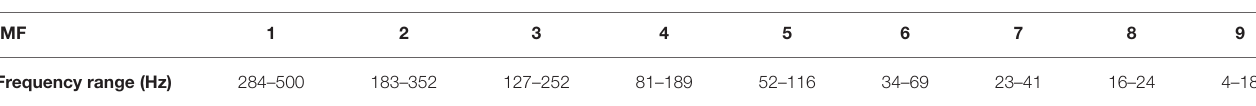
TABLE 1 | Frequency ranges of first nine IMFs determined by 3dB